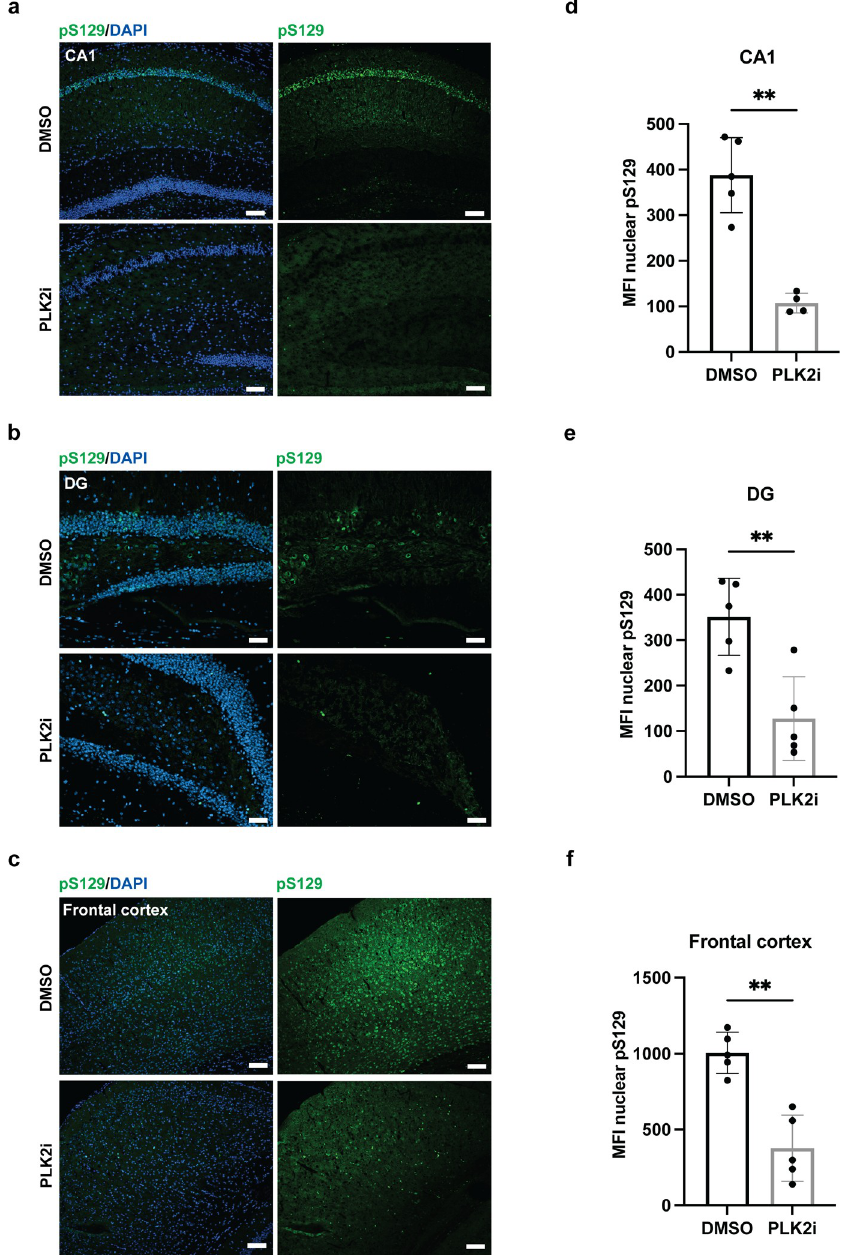
Fig 5. PLK2i treatment for 48 hours before sacrifice reduces nuclear pS129-staining in PFF-injected M83 mice. a- c) Representative images from the CA1 region (a) and the DG (b) of hippocampus, and the frontal cortex (c) of 15-month-old M83 mice– 3 months following PFF injection in the hindlimbs–stained with pS129 (D1R1R) and DAPI, showing particularly strong pS129-staining at pyramidal neurons of the CA1 region. 48-hour PLK2i treatment by oral gavage (2 x 100 mg/kg/day) significantly reduces nuclear pS129-staining in all regions, although some PLK2i resistant S129-phosphorylation is apparent in the frontal cortex. Scale bars = 50 μ m. d-f) Quantification of the mean fluorescence intensity of nuclear pS129 in CA1 with 73.3% reduction following PLK2i treatment, p-value = 0.0010 (d), in DG with 63.7% reduction, p-value = 0.0040 (e), and in the frontal cortex with 62.5% reduction, p-value = 0.0011 (f). All comparisons were made using an unpaired Welch’s T test. Bars represent the mean ± SD, n = 5 mice in each group. � p < 0.05, �� p < 0.01.